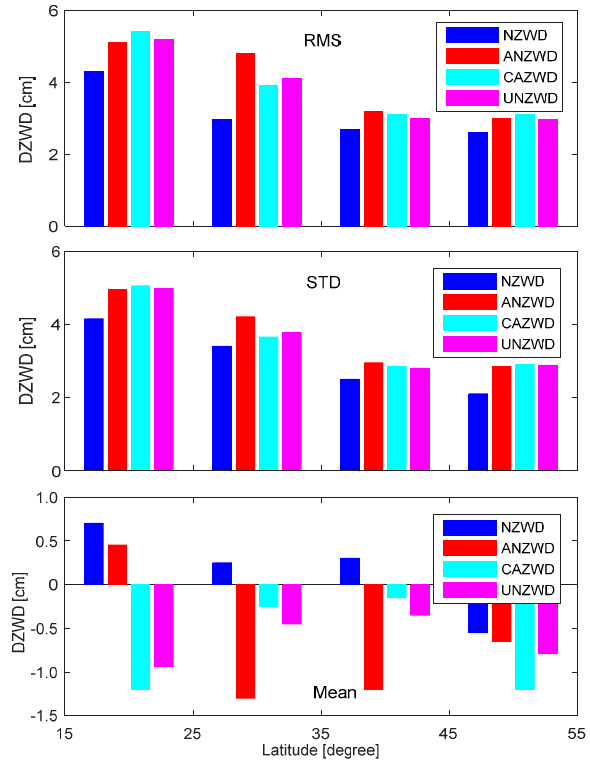
Figure 7. The accuracy of the three ZWD models at different latitudes relative to GNSS PPP.